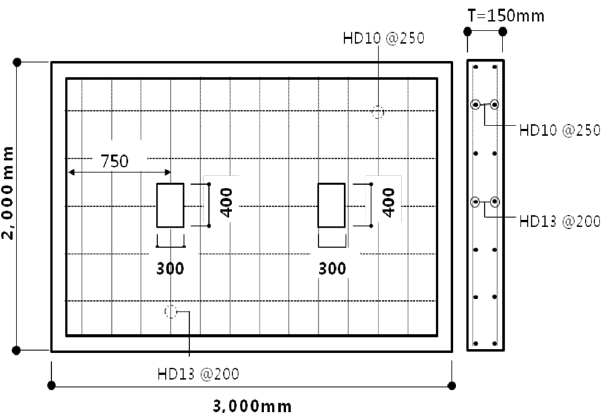
Figure 2. Details of